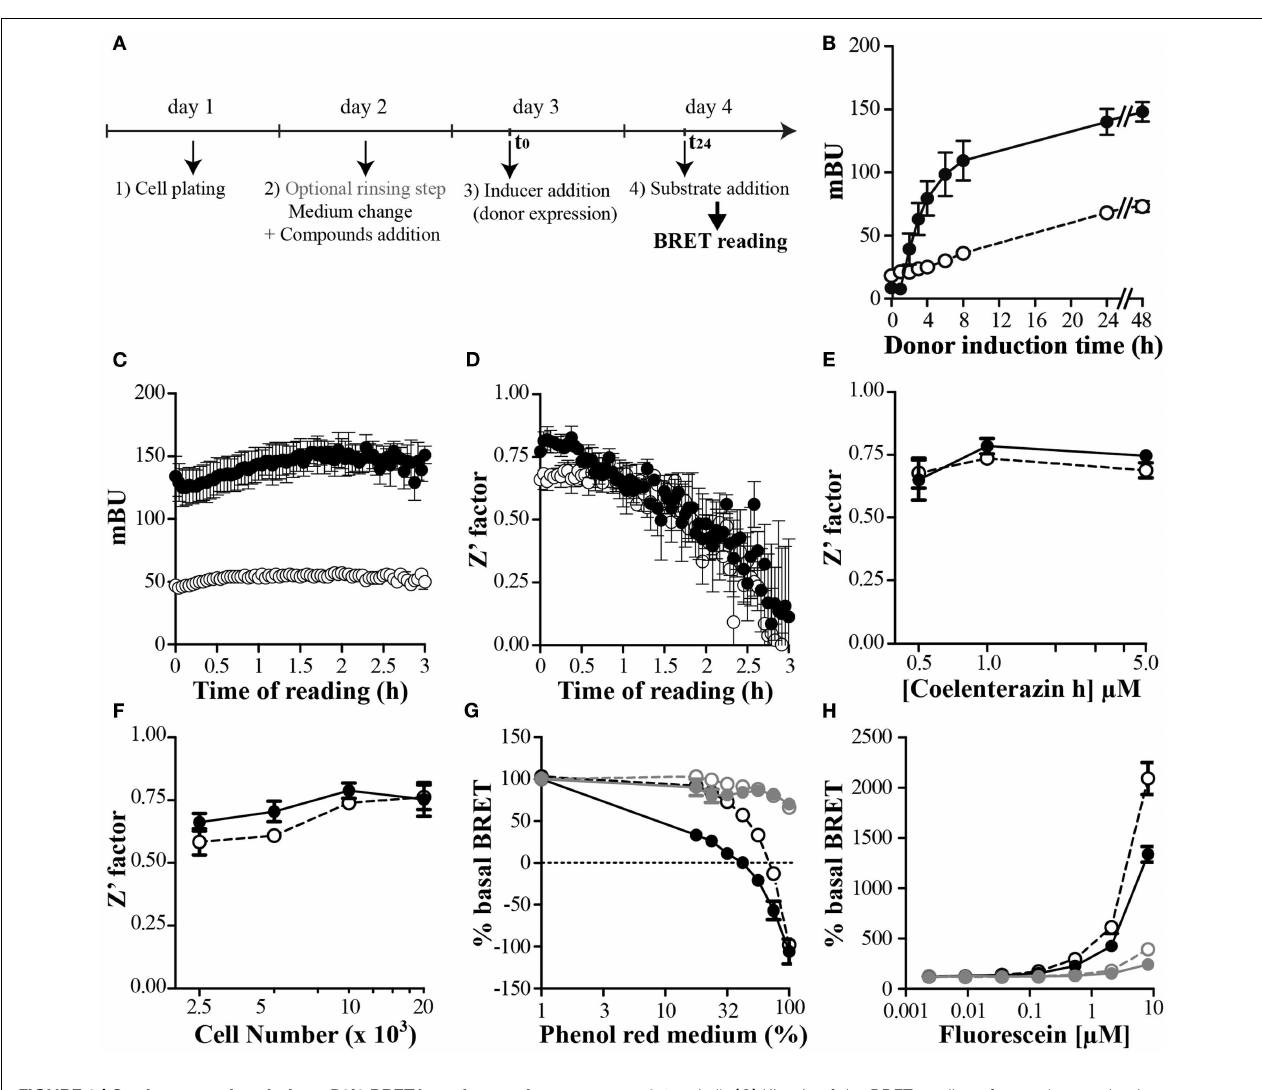
0.1 µ g/ml). (C) Kinetic of the BRET reading after coelenterazine h FIGURE 3 | Setting up and optimize a P2I2 BRET-based screening addition and (D) effect on the Z (cid:48) factor calculated from 8 points. n = 3. assay. (A) Basic protocol of P2I2 BRET-based screening assay; (B–H) parameters analysis of the BRET signal monitored using (E) Effect of substrate concentration or cell number used (F) on the Z (cid:48) • ◦ OBRc/OBRGRP ( ) and CD4/PLSCR1 ( ) BRET-based screening factor (from 8 points). n = 3; (G) dose dependent effect of red phenol or Fluorescein (H) interfering compound in the medium when reading assays, engineered using CHO-Trex cell lines to allow doxycyclin BRET. In gray when medium was removed before reading: induction of donor. n = 3; (B) kinetic of the BRET induction: BRET signal • ◦ monitored as a function of time after inducer addition (doxycyclin OBRc/OBRGRP ( ) and CD4/PLSCR1 (